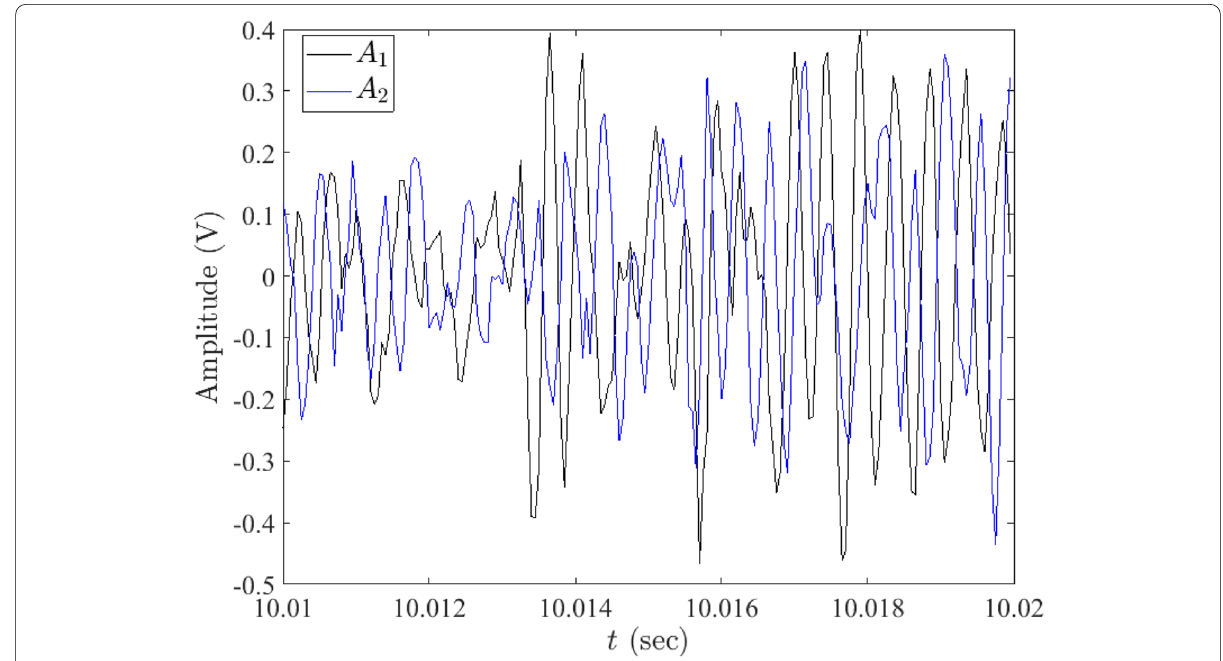
Fig. 14 Time history of AE data of a typical segment for damage at D